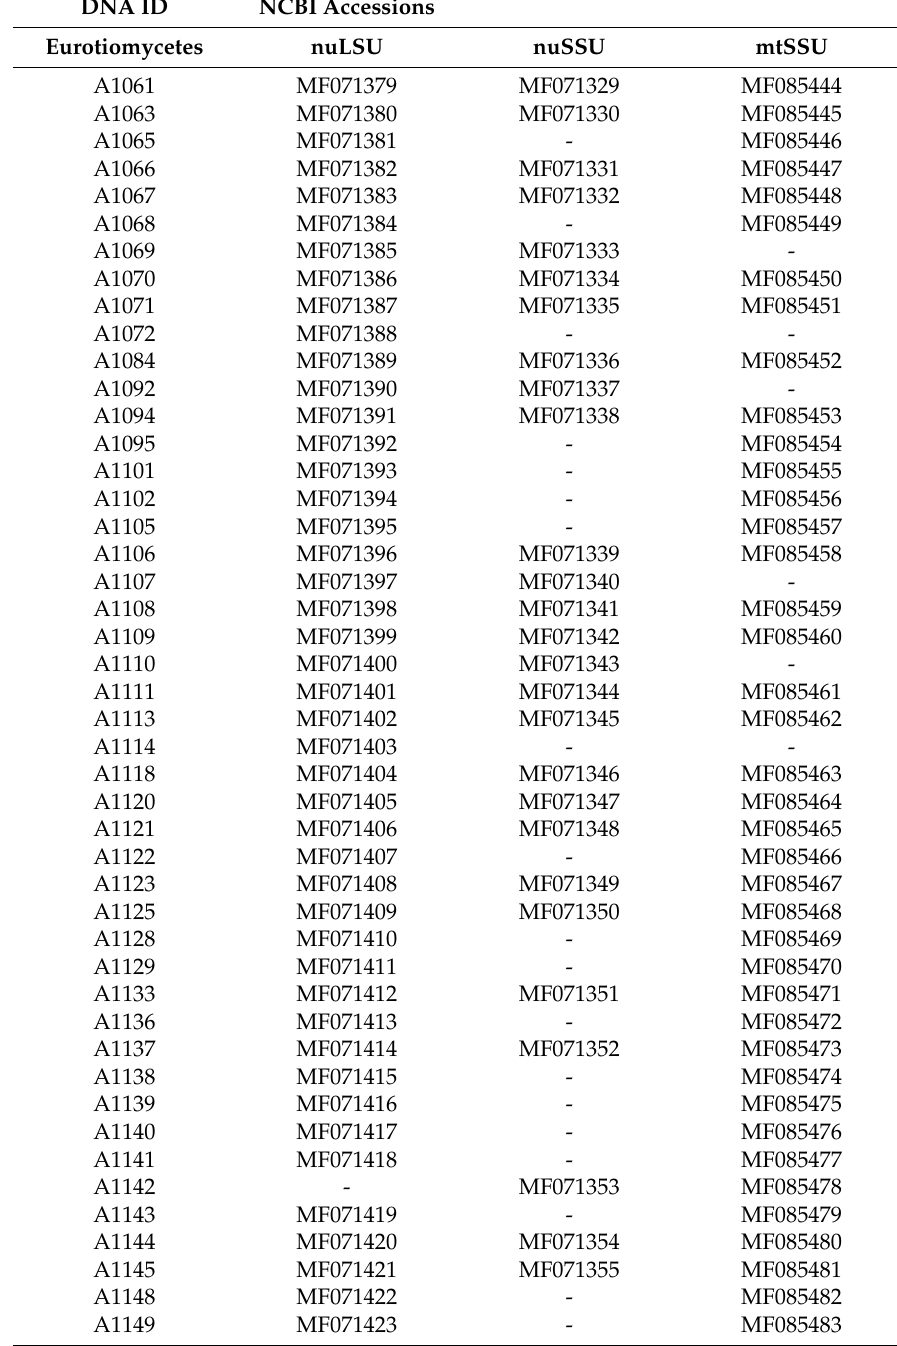
Table A2. NCBI accession numbers for the newly characterized isolates of lichen-inhabiting fungi included in the phylogenetic analyses of Appendix